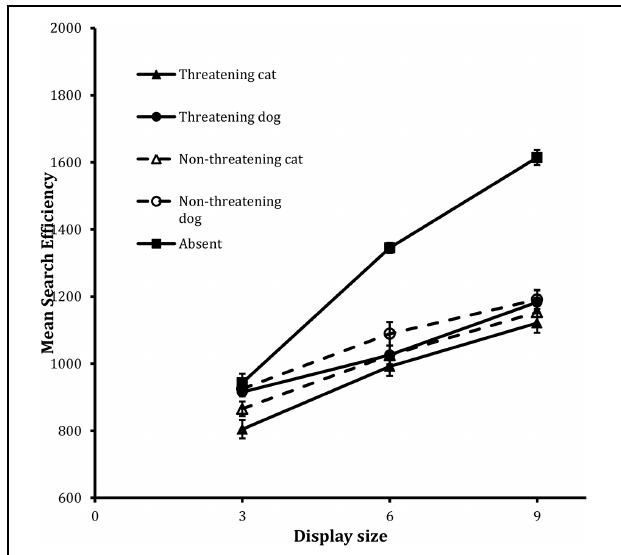
FIGURE 3 | Mean search efficiency scores as a function of both condition and display set size in the detection task in Experiment 2. Error bars reflect within-participant SE after variation between participants was removed (after Bakeman and McArthur, 1996).